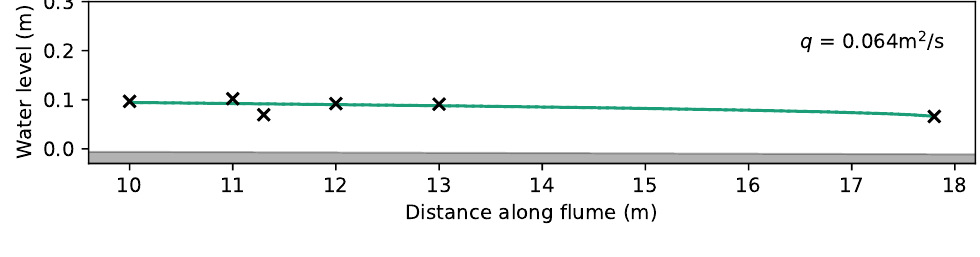
Figure A1. Results for configuration (a).